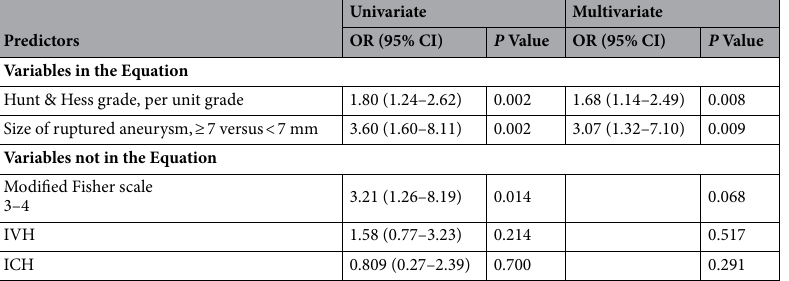
Table 2. Multivariable logistic regression model results of myocardial biomarker elevation. ICH intracerebral hemorrhage, IVH intraventricular hemorrhage.